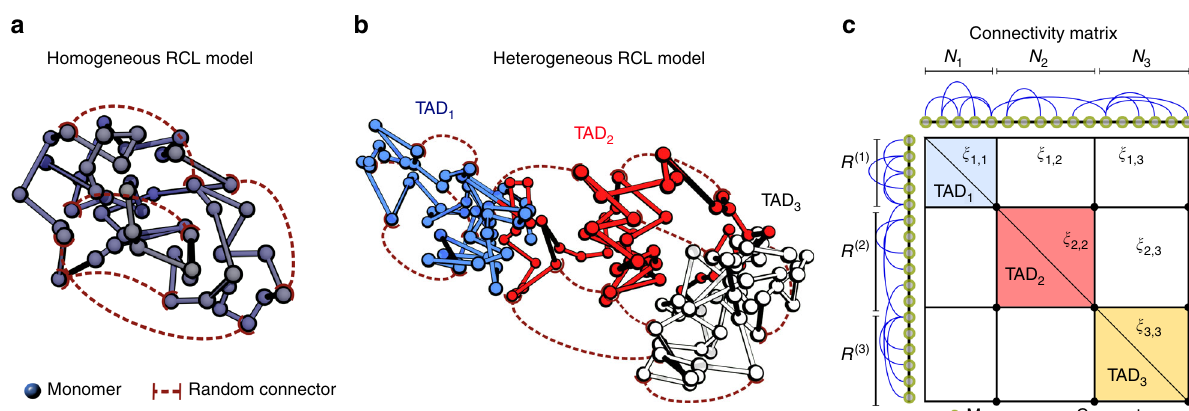
Fig. 6 RCL polymer model for single and multiple interacting associating domains. a Schematic representation of the RCL polymer for a single topologically associating domain (TAD). Monomers (circles) are connected sequentially by harmonic springs to form the polymer ’ s backbone (gray). Spring connectors (dashed red) are added between randomly chosen non nearest-neighbor monomers. The choice of monomer pairs to connect is randomized in each realization. All monomers share similar average level of connectivity (homogeneous RCL model). b Schematic representation of the RCL polymer model for three connected TADs (blue, red, white), where monomers (circles) are randomly connected (dashed red) within and between TADs by springs. Monomer connectivity within and between TADs can vary (heterogeneous RCL model). c Schematic representation of the symmetric connectivity matrix B G ð Ξ Þ , corresponding to the connected monomers over the three TADs in panel ( b ) (diagonal bocks), where each TAD is of variable number of monomer N